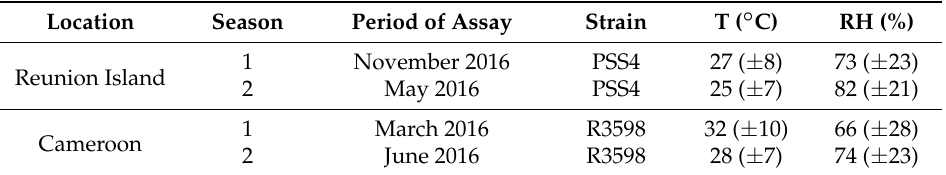
Table 6. Description of the location, period of assay, strain used for the inoculation, and mean Temperature (T ( ◦ C)) and Relative Humidity (RH (%)) (with standard errors) measured during the phenotyping assays conducted on the DH population EG203 ×